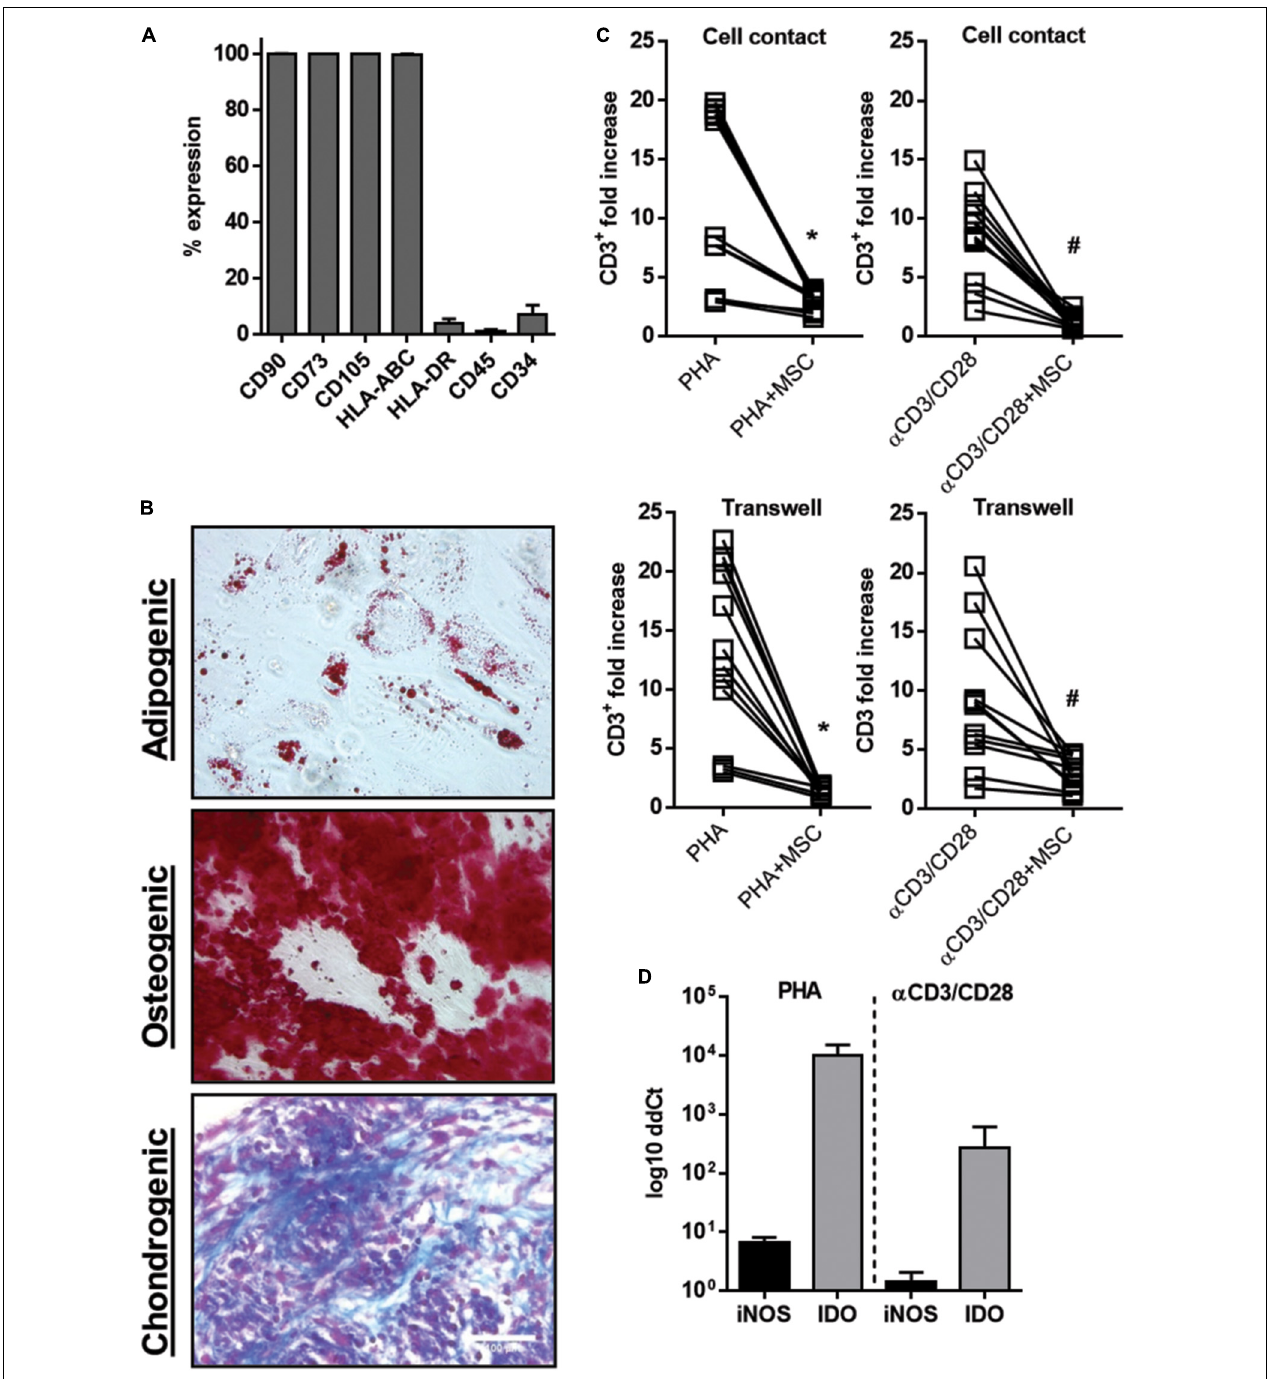
FIGURE 1 | UC-MSC inhibit T cell proliferation induced by PHA and TCR stimulation. (A) Percentage of UC-MSC expressing the cell markers CD90, CD73, CD105, HLA-AB, HLA-DR, CD45, and CD34 ( n = 4). (B) Representative micrographies of adipogenic, osteogenic, and chondrogenic differentiation of UC-MSCs in passage 4–5 ( n = 4 donors). MSCs were induced to differentiate toward osteogenic lineage and verified by alizarin red staining, adipogenic lineage and verified by Oil Red and chondrogenic lineage, verified by alcian blue (magnification = 100 × ). (C) PBMNC ( n = 4 donors) were stimulated for 5 days with PHA (1 µ g/ml) or anti-CD2, -CD3, -CD28 ( α CD3/CD28) in presence of UC-MSC ( n = 3) in a ratio of 10:1 (PBMNC:UC-MSC). Cells were co-cultured in direct contact or in a transwell system, collected and stained with an anti-CD3 antibody. Absolut CD3 counts were determined by counting beads in a flow cytometer. Fold increase ratio of CD3 + proliferation was calculated relatively to cell numbers of untreated controls. Data is represented in mean ± SEM. *PHA vs. PHA+UC-MSC, p = 0.0001; # α CD3/CD28 vs. α CD3/CD28+UC-MSC, p < 0.00001. (D) RNA from UC-MSC in transwell experiments was collected. Thereafter, a real-time RT-PCR was performed to quantify indolamine-2,3-dioxygenase (IDO) and inducible NO synthase (iNOS) levels. Log10 ddCt values were calculated relative to UC-MSC in basal culture condition.